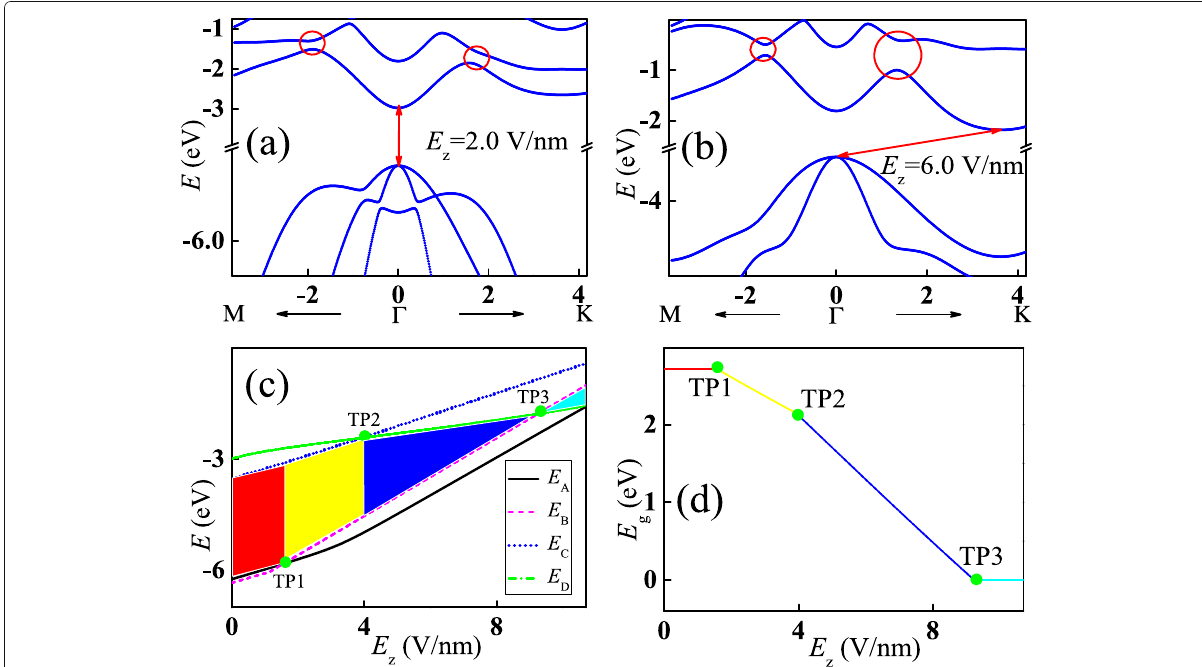
Fig. 3 (Color online) Energy bands of the perpendicular electric field-modulated monolayer InSe at different strengths E z = 2.0 V/nm( a ) and 6.0 V/nm ( b ), respectively. Red circles in a and b mean the opened energy gaps around the crossing points shown in Fig. 1c. c Energies at points A (the black solid line), B (the magenta dashed line), C (the blue dotted line), and D (the green dash-dotted line) shown in Fig. 1c as a function of the electric field strength. d Global band gap as a function of the strength of the electric field. The yellow line means the direct band gap while the red and blue lines indicate the indirect band